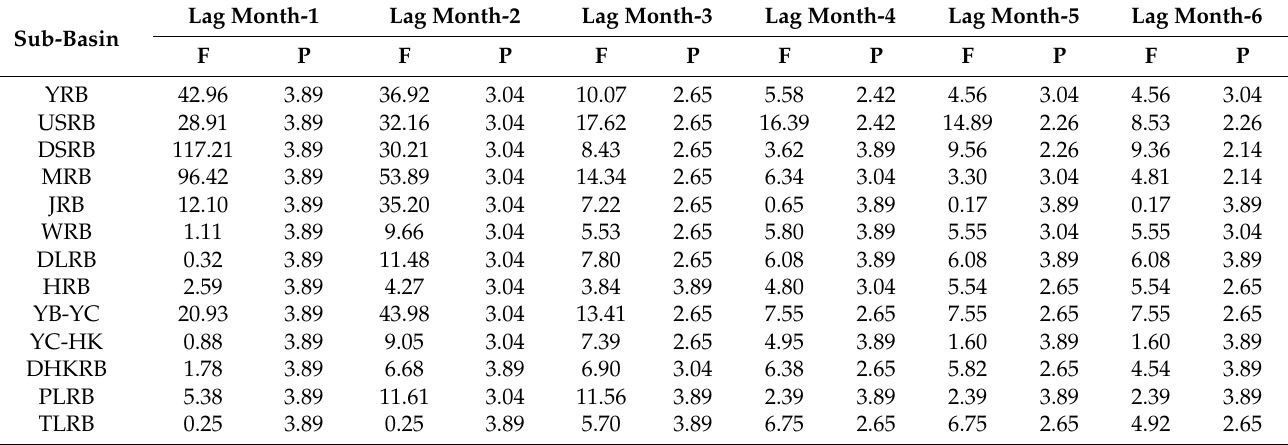
Table 3. Granger’s Causality test between SMA and FPI in the YRB and its sub-basins at the lags of 1–6